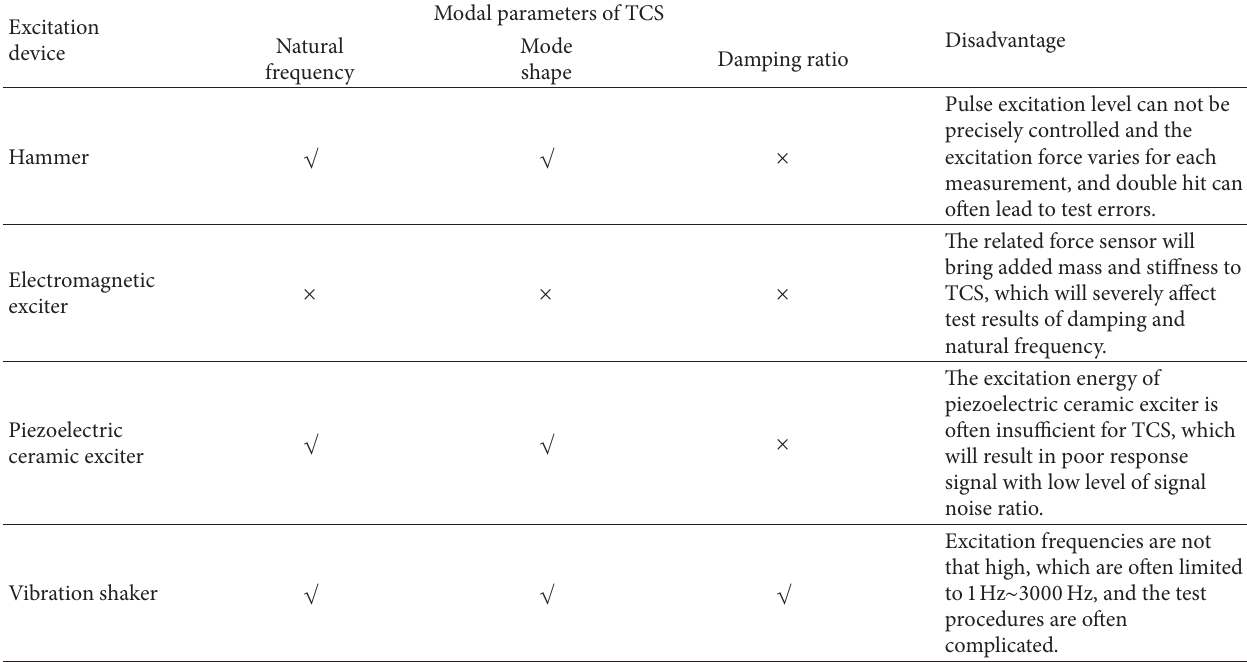
Table 6: The disadvantages of different vibration excitation devices for modal test of TCS under under bolt looseness